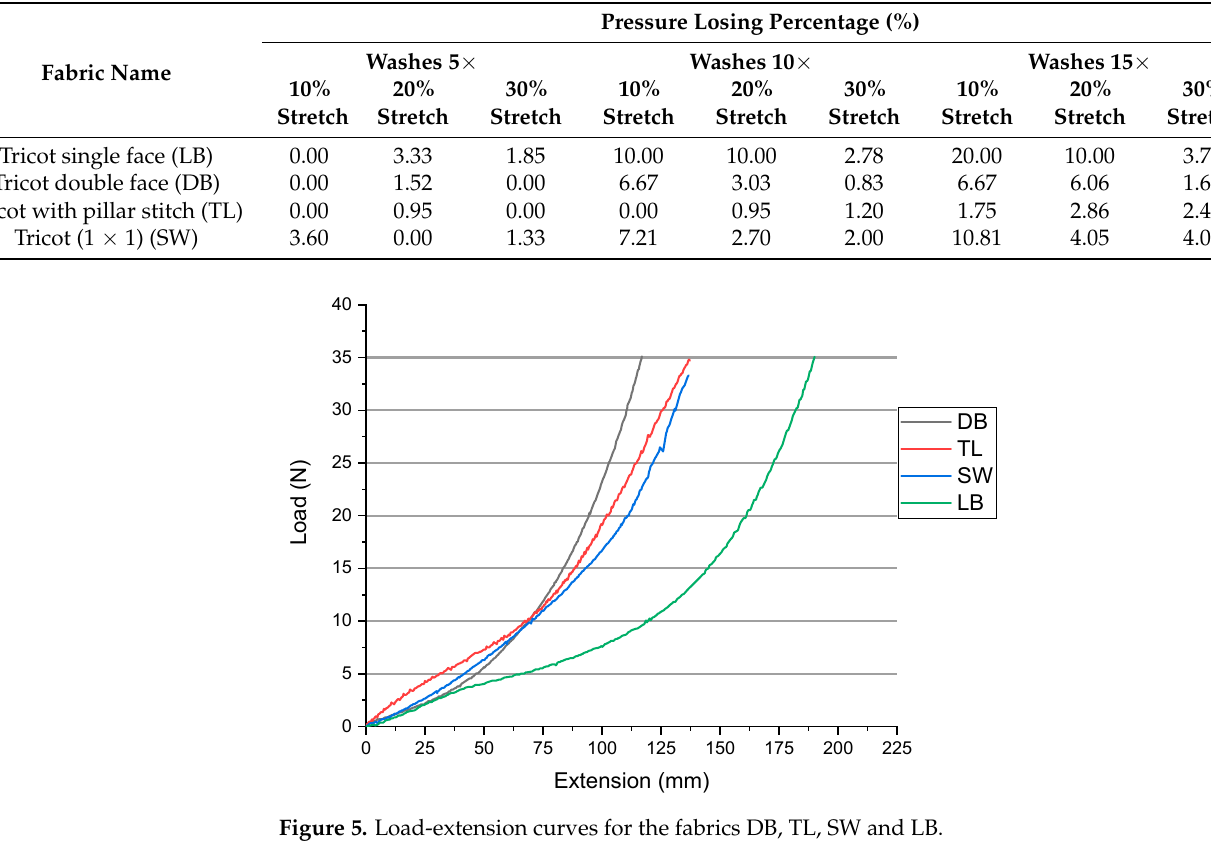
Table 2. Pressure loss after 5, 10 and 15 washing cycles of the fabrics LB, DB, TL and SW mounted at 10%, 20% and 30% stretch on the rigid cylinder.